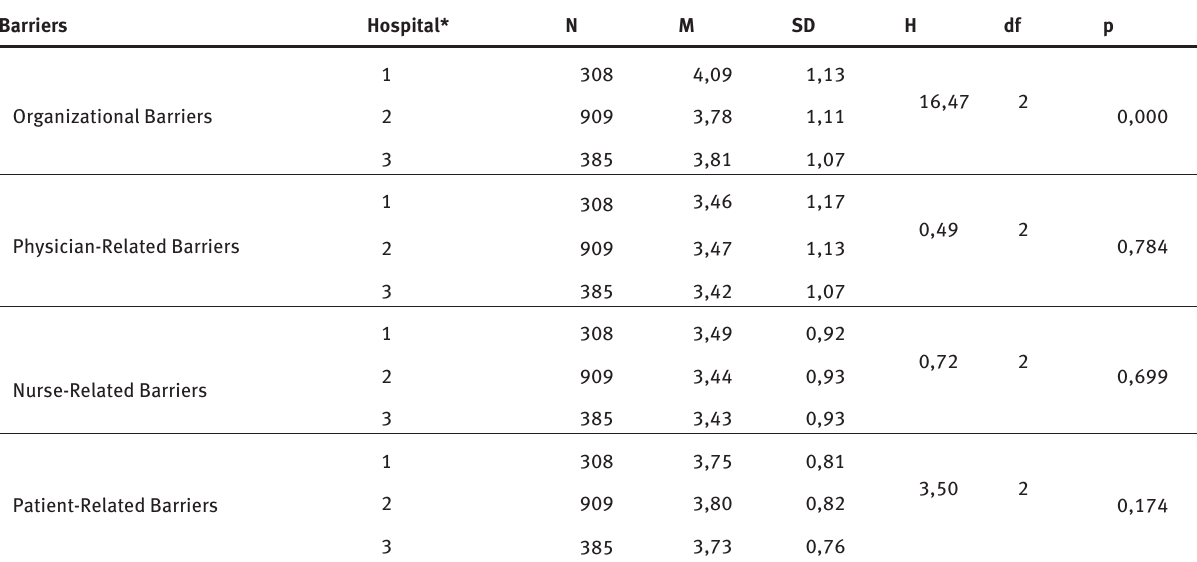
Table 7: Type of hospital and perception of problems by nurses.